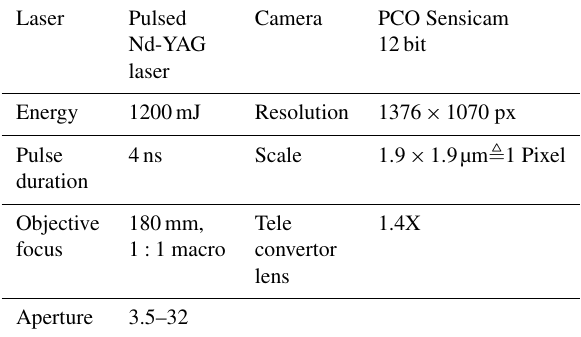
Table 3. Characteristic numbers of shadowgraphy